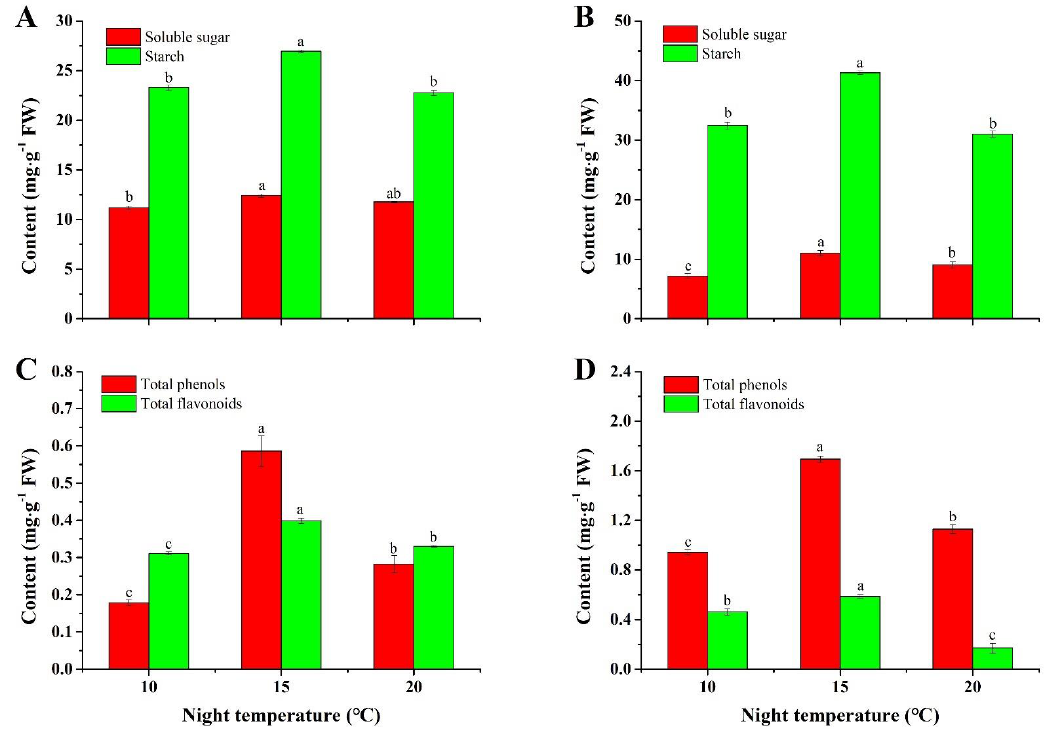
Figure 2. Contents of soluble sugar, starch, total phenols, and flavonoids in A. membranaceus ( A and C ) and C. lanceolata ( B and D ) plug seedlings as affected by night temperature. Data are presented as the mean ± standard error (n = 3). Different letters (a, b, and c) indicate significant differences among treatments by Duncan’s multiple range test at a 0.05 level.